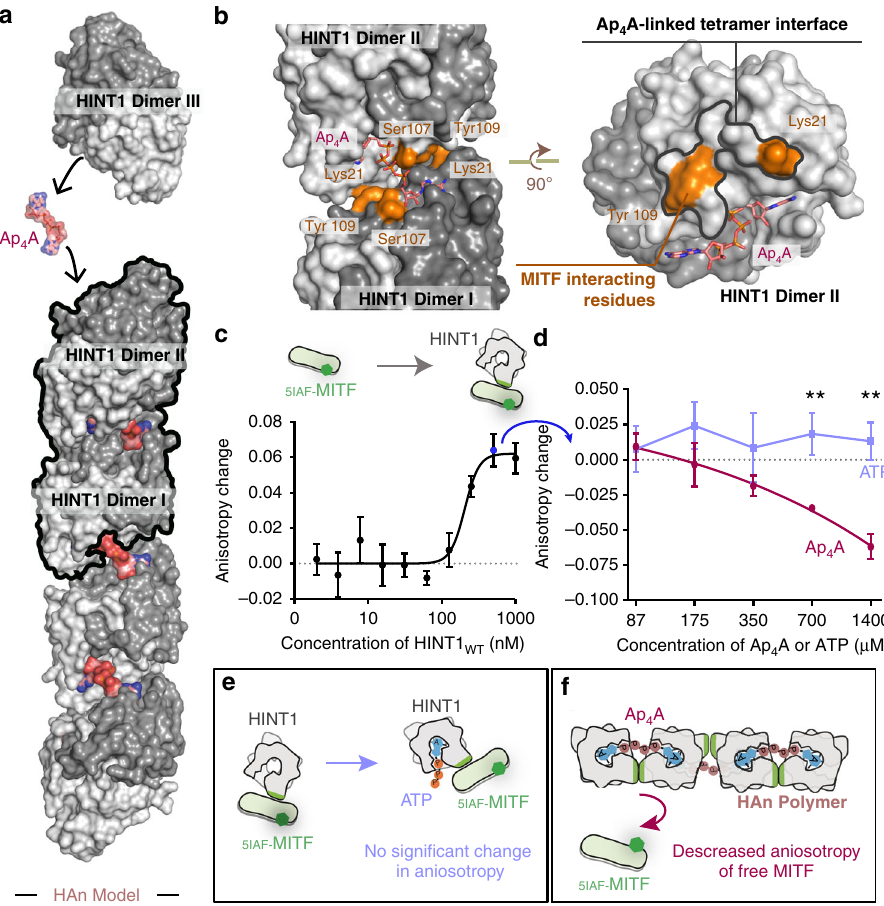
Fig. 3 HAn formation breaks HINT1-MITF interactions in solution. a A model of (HINT1-Ap 4 A) n polymer, denoted as HAn, is built based on the HINT1- Ap 4 A tetramer observed in the crystal structure (circled with a black line). b Interface for MITF (labeled as yellow) overlaps with Ap 4 A-induced tetramer interface (circled with a black line). Posttranslational modi fi cation sites of HINT1 (yellow) is located at the tetramer interface of HINT1. Among them, Lys21 and Tyr109 were reported to directly bind MITF, and modi fi cation on these sites disrupted MITF-HINT1 interaction and released MITF transcription activity. c Fluorescence anisotropy assay designed to monitor the interaction between HINT1 WT and 5IAF- MITF. Error bars represent the SD of three experimental repeats. Source data are provided as a Source Data fi le. d Titration of Ap 4 A and ATP into the 5IAF- MITF-HINT1 WT complex at the platform of c . Error bars represent the SD of three experimental repeats. ** P < 0.01, from two-tailed Student ’ s t -test. Source data are provided as a Source Data fi le. e ATP could not induce HINT1 polymerization and could not release 5IAF- MITF to decrease the fl uorescence anisotropy. f Ap 4 A was able to induce HINT1 polymerization and release 5IAF- MITF to decrease the fl uorescence